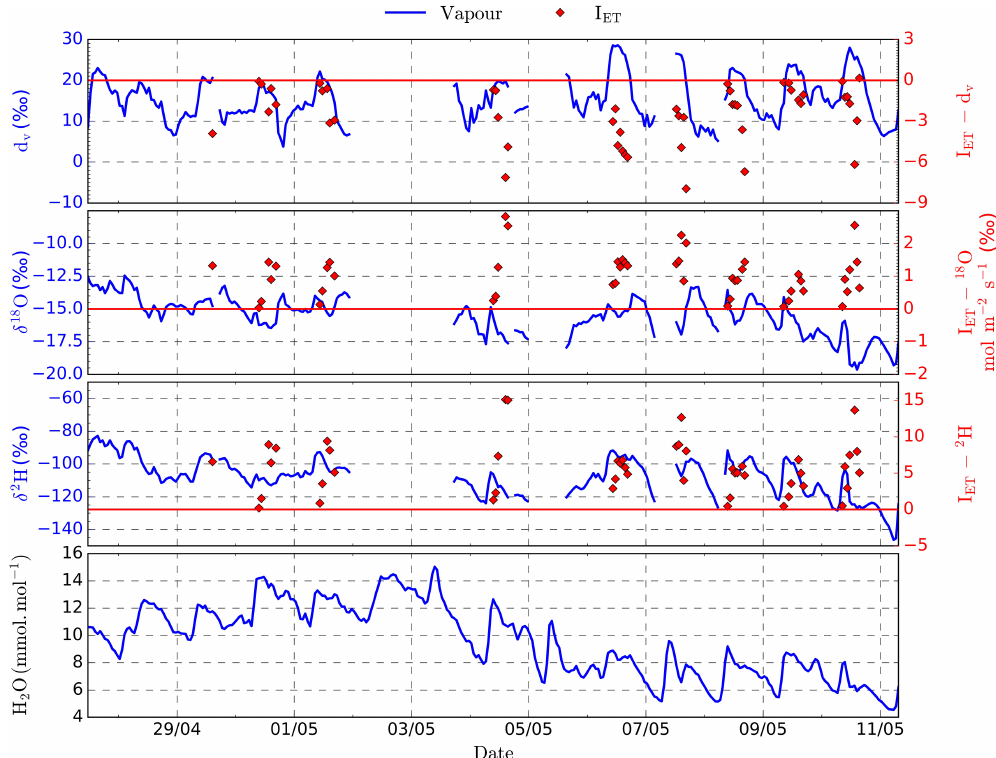
Figure 7. Time series of hourly water vapour mixing ratio, isotopic composition and ET isoforcing ( I ET